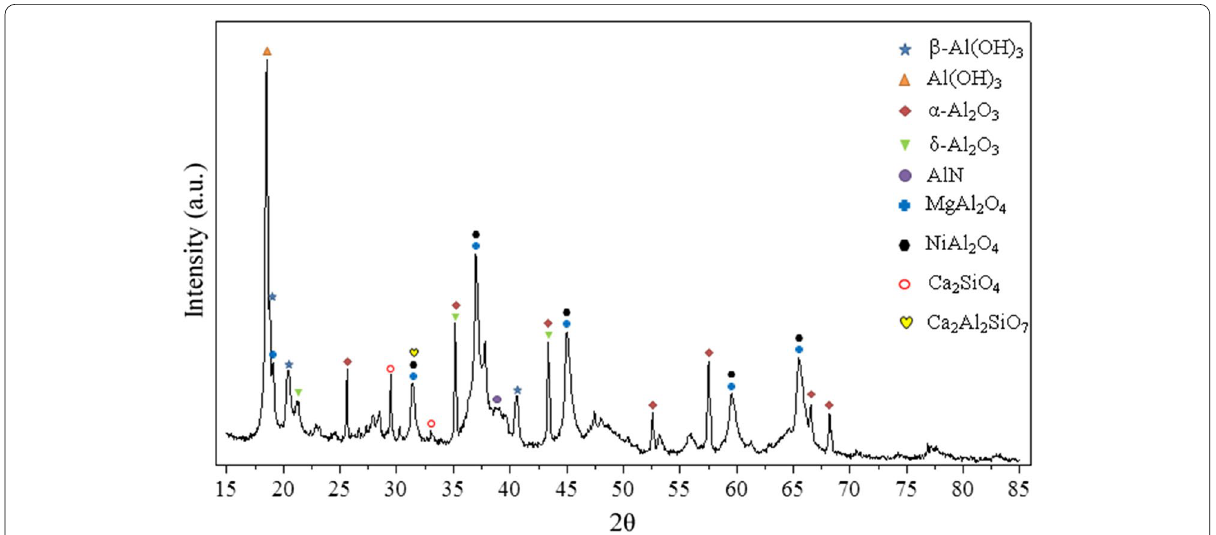
Fig. 3 X‑ray diffraction pattern of sample aluminum